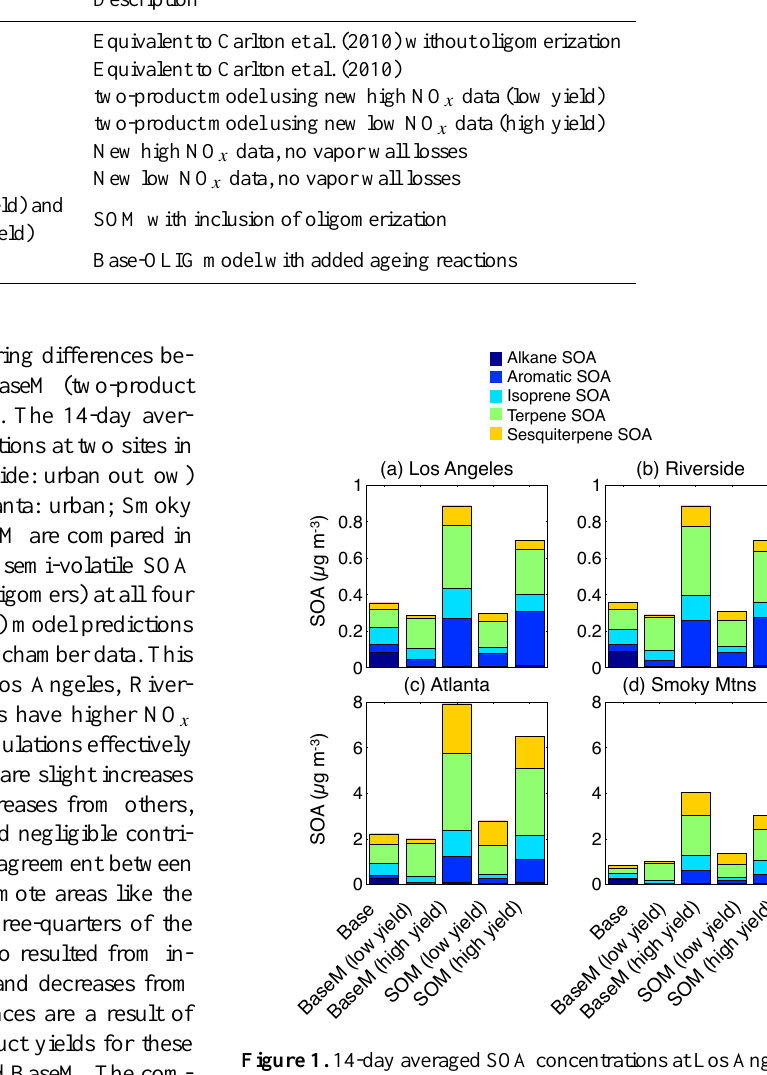
Table 1. Simulations performed in this work. Simulation